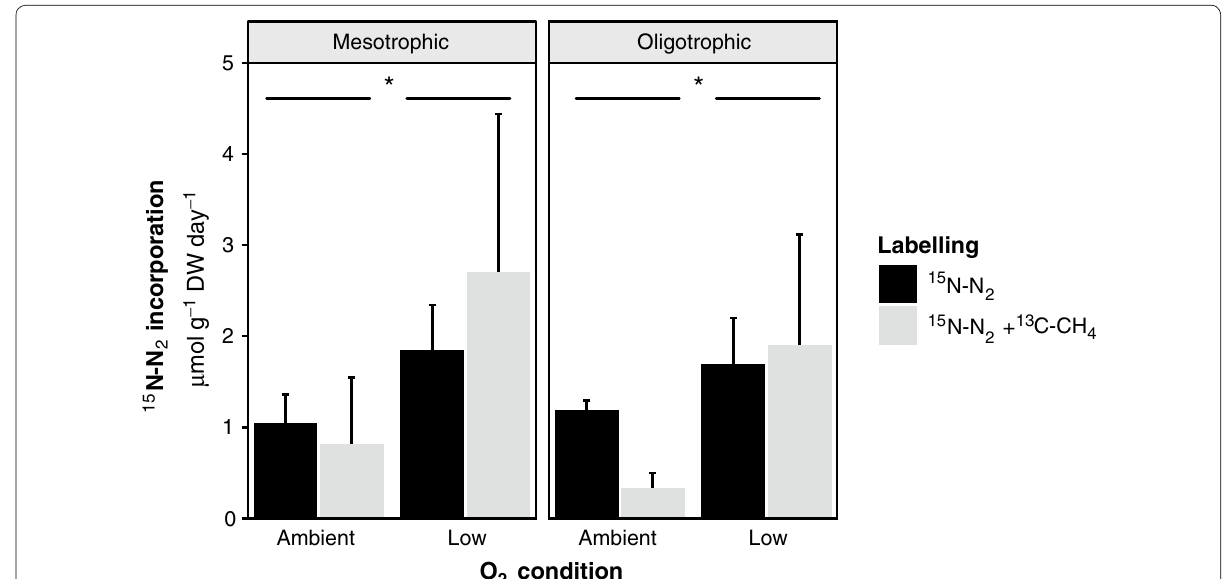
Fig. 1 Incorporation of 15 N–N 2 (μmol g − 1 DW day − 1 ) in the mesotrophic fens (n incubated with ambient O